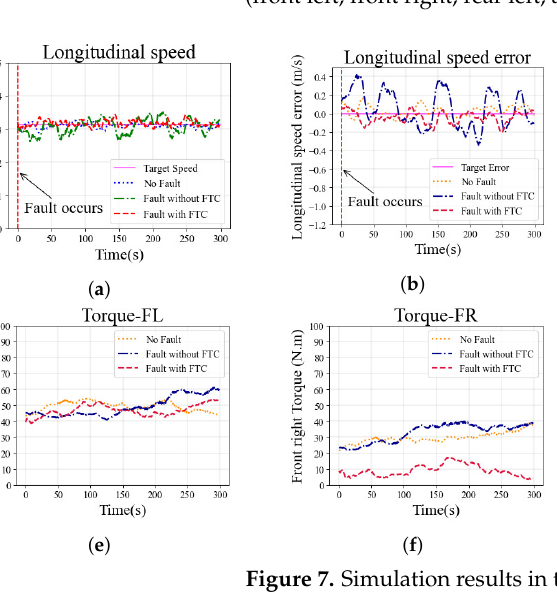
Figure 6. Simulation results in the straight scenario with fault F ∗ tudinal speed; ( b ) Longitudinal speed error; ( c ) Yaw rate; ( d ) Heading; ( e – h ) Torque on each wheel (front left, front right, rear left, and rear right).